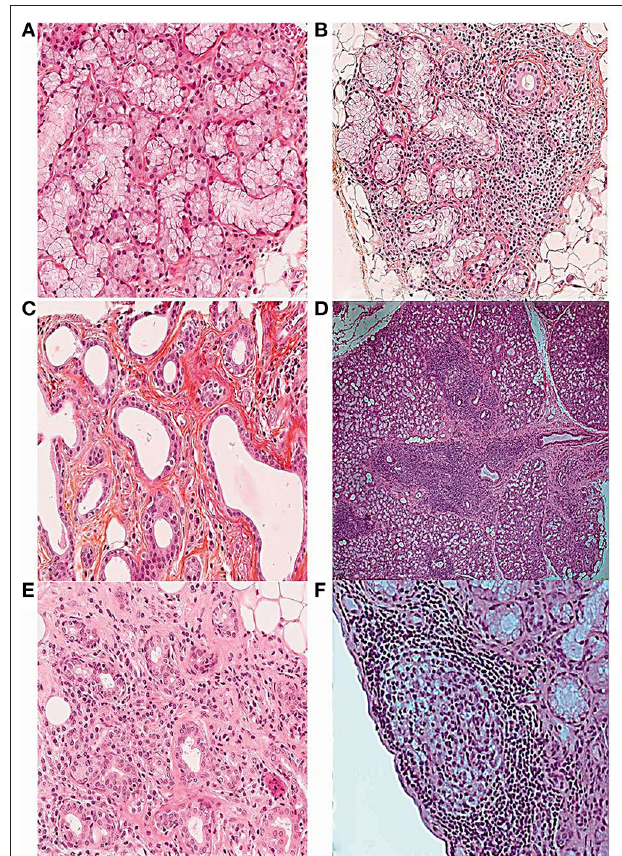
FIGURE 1 | Histopathological features of the minor salivary gland biopsy in patients with SS stained with hematoxylin, eosin and saffron (16). (A) Normal salivary gland tissue (10 × ). (B) Focal lymphocytic sialadenitis (FLS) with perivascular or periductular aggregates of > 50 lymphocytes (10 × ). (C) Dilated ducts of the minor salivary gland biopsy (10 × ). (D) FLS surrounded by normal gland tissue (4 × ). (E) Non-specific chronic sialadenitis (NSCS) with acinar atrophy, interstitial fibrosis and scattered mononuclear cell infiltrates (10 × ). (F) FLS with germinal center-like structure (10 ×